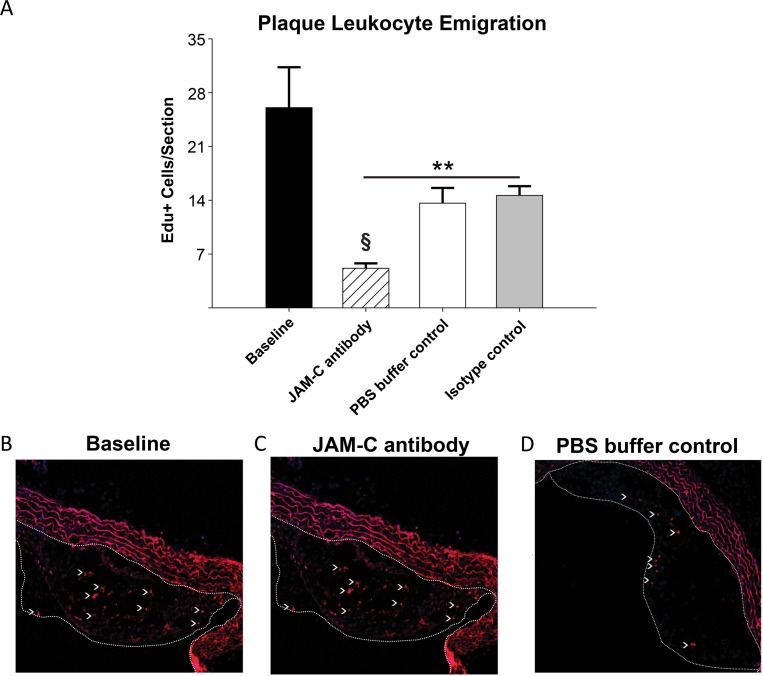
Increased atherosclerotic lesion regression following blockade of JAM-C is concurrent with increased leukocyte emigration from plaques.48-hrs prior to transplantation or immediate sacrifice, all donor ApoE-/- mice fed 12-wks of WD were injected with EdU (2mg/kg, i.p) to incorporate into DNA of monocyte precursors proliferating in the bone marrow. EdU-labeled circulating monocytes then enter the circulation and are recruited into atherosclerotic plaques. (A) Emigration from the plaques was quantified as the decrease in the number of EdU+ cells per section in the aortic arch plaques in baseline mice, compared to after transfer to the normolipidemic recipients. (B) Donor mice sacrificed at the transplant time point show robust EdU+ labeling in the aortic arch lesions. Recipient mice sacrificed 4-days after transplantation show significant reduction of EdU+ cells, indicating emigration during regression. (C) Recipient mice in which JAM-C was blocked via injections (JAM-C antibody) demonstrate even higher leukocyte egress than recipients treated with the isotype control (not shown) or (D) PBS buffer control. Lesions are outlined from endothelium with dashed white line. Data are presented as the mean value ±SEM (N = 6). ** = P<0.01 compared to baseline measurements. § = P<0.05 compared to WT and IgG recipients.